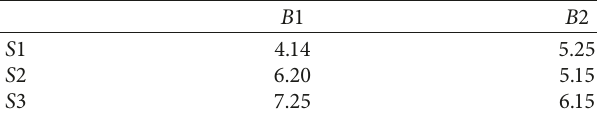
Table 7: Exponential mean cost from B1 and B2 to C1 (in $). Table 8: Exponential mean cost from S1, S2, and S3 to B1 and B2 (in